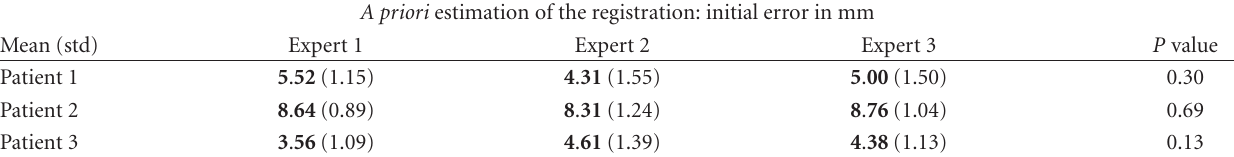
Table 1: Manual estimation of the initial error in mm (i.e., error of the registration given by the neuronavigation system). A priori estimation of the registration: initial error in